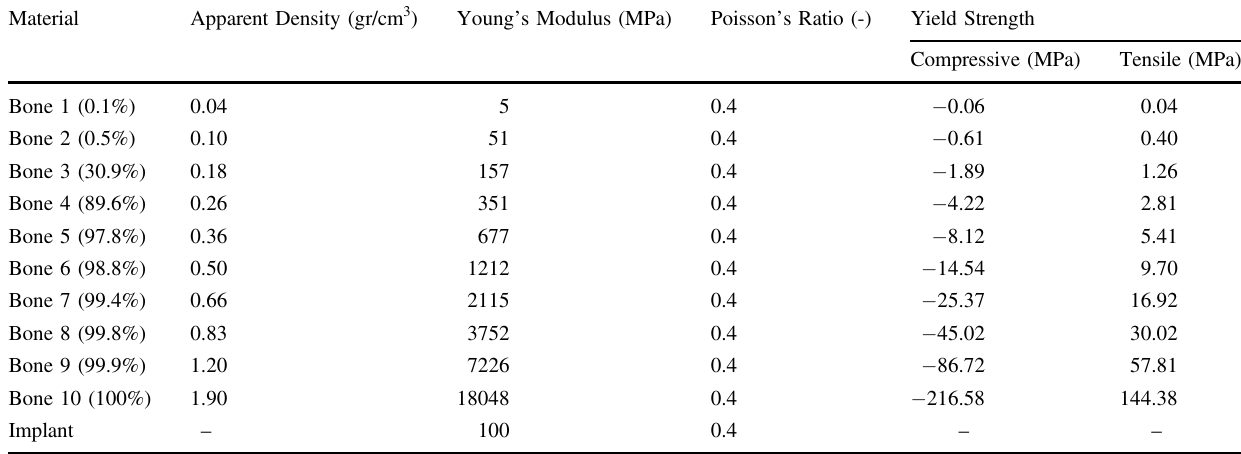
Table 1 Mechanical properties of the materials used in the present study. For the different bone tissues (1 until 10) the percentage signi fi es the cumulative amount of bone elements belonging to this speci fi c tissue Material Apparent Density (gr/cm 3 ) Young ’ s Modulus